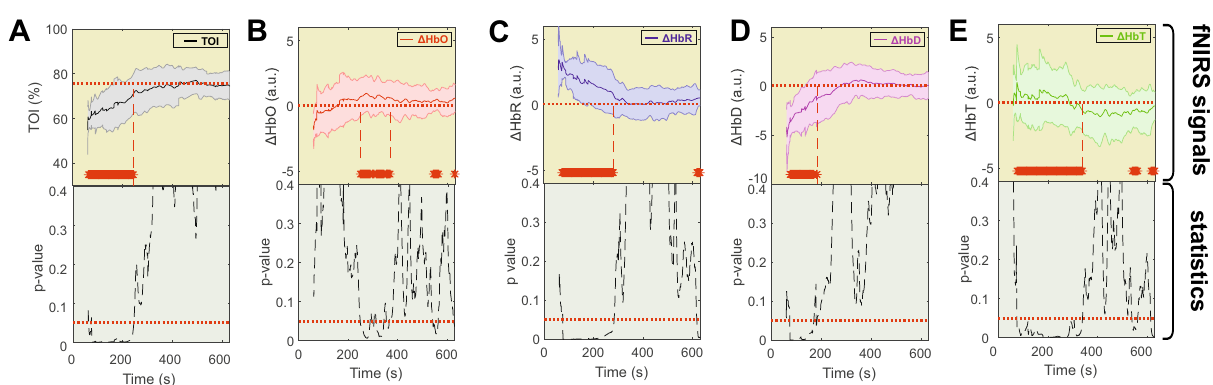
Figure 2. The hemodynamic parameters TOI, [ΔHbO], [ΔHbR], [ΔHbD], and [ΔHbT] are presented during the recording as the mean ± std in panels ( A ) to ( E ), respectively. The red dotted line shows the reference value in each panel. The red bar corresponds to the time window in which the parameters were verified to be significant. The statistical results are presented below each panel. The dotted red line shows the statistical threshold ( p =